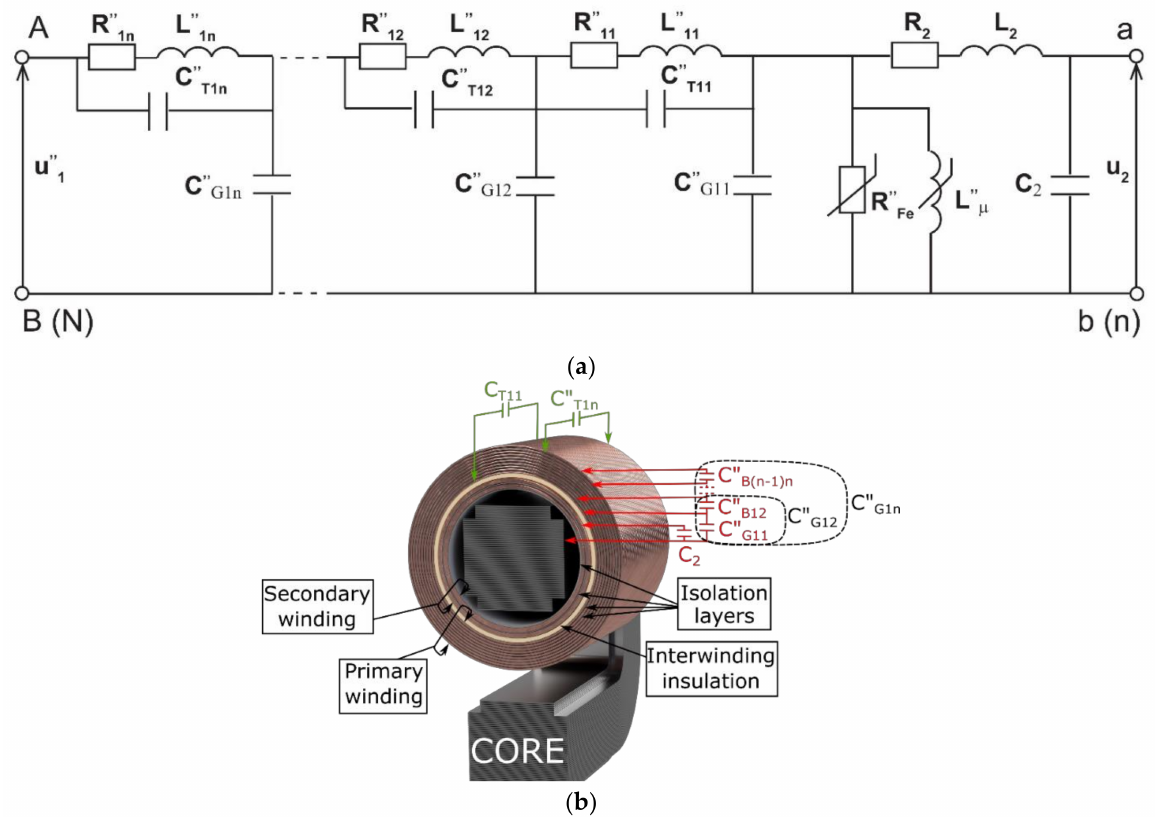
Figure 1. The model of inductive VT: ( a ) extended equivalent circuit in the frequency range up to 20 kHz, ( b ) rendering of an inductive VT. In Figure 1 the following notations are used: symbols with two dashes (‘’) indicate parameters converted to a secondary